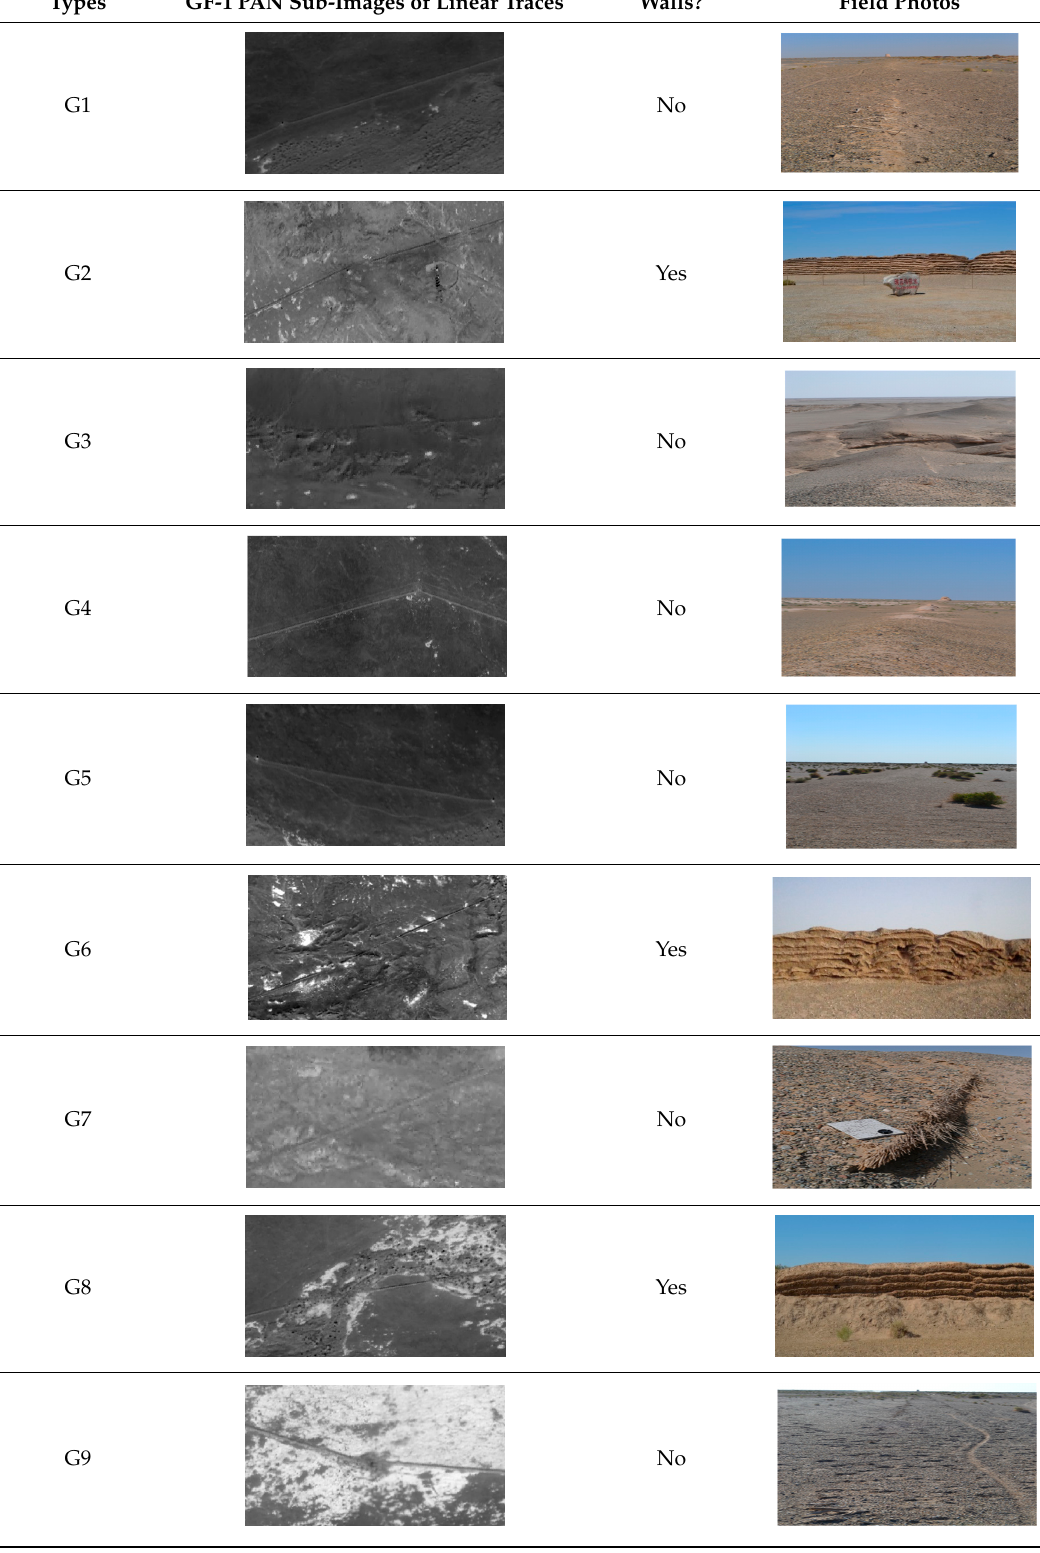
Table 3. Image characteristics of 12 typical linear traces in GF-1 PAN data.